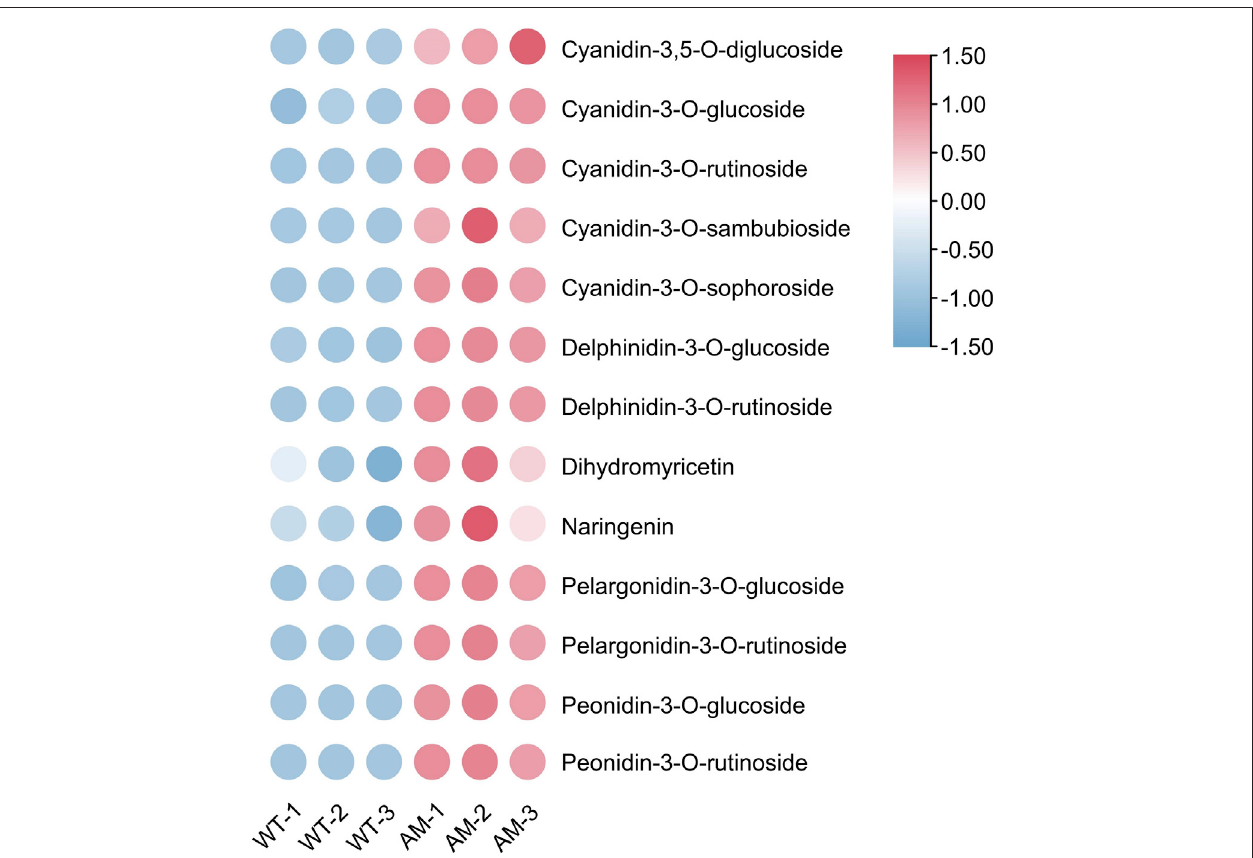
FIGURE 4 | The differentially accumulated metabolites (DAMs) of anthocyanin accumulation between WT vs. AM.